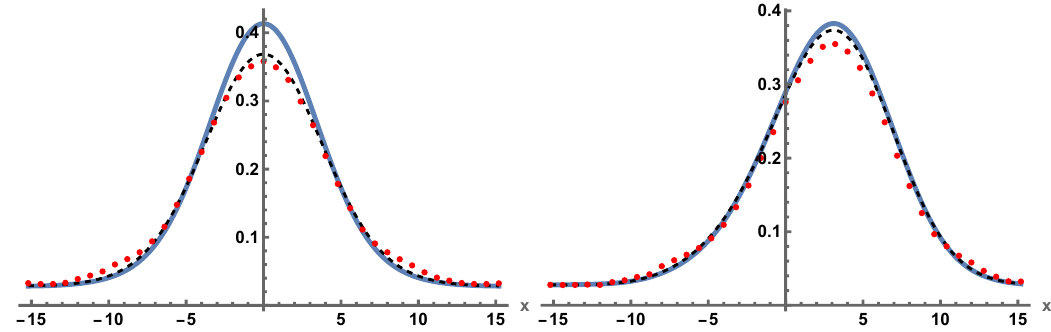
Figure 11 . The energy density at zeroth order (solid blue curve) in the central region y = 0 , z = 0 (left) as well as at z = 2 . 1 (right) at time t = 2 . The red dotted curve represents the exact results, while the black dashed curve includes the partial O ( (cid:15) 2 ) corrections discussed in section